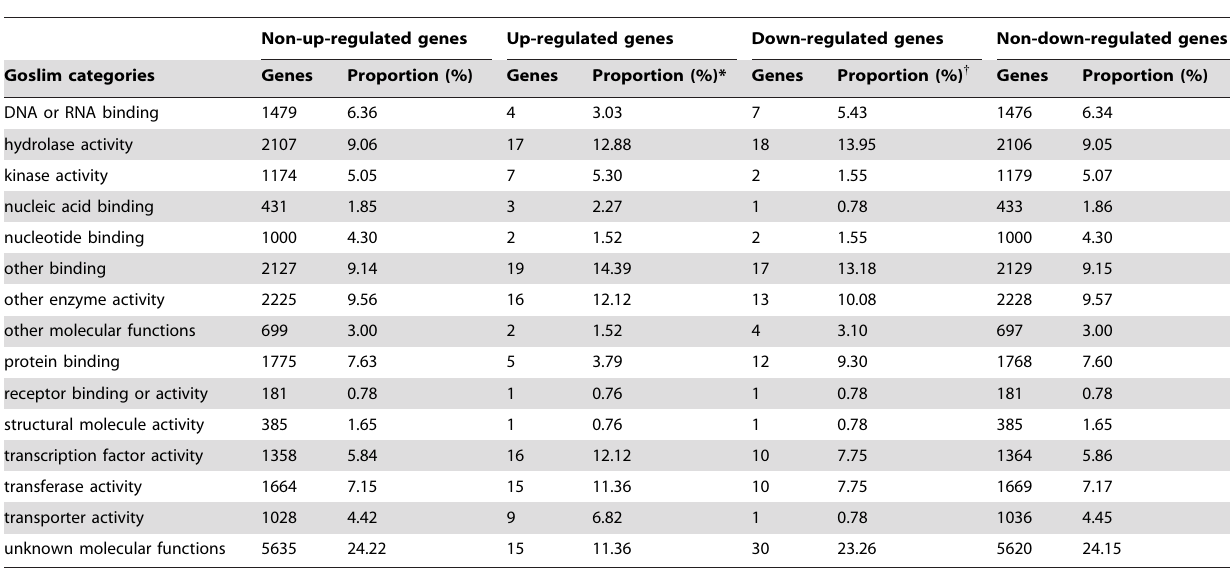
Table 1. Goslim categories in molecular function (MF) of differentially expressed genes and non-differentially expressed genes in dcl1-7 , hen1-1 , hyl1-2 and hst15 .